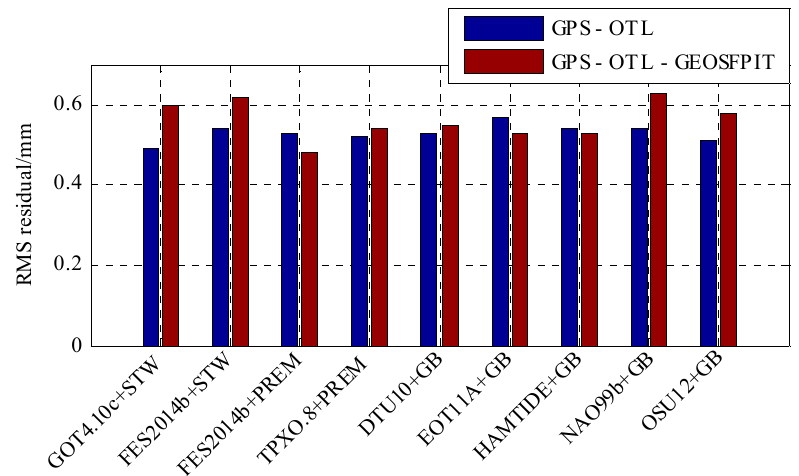
Figure 6. RMS residual of the S2 tidal constituent between the GPS estimates and the OTL models